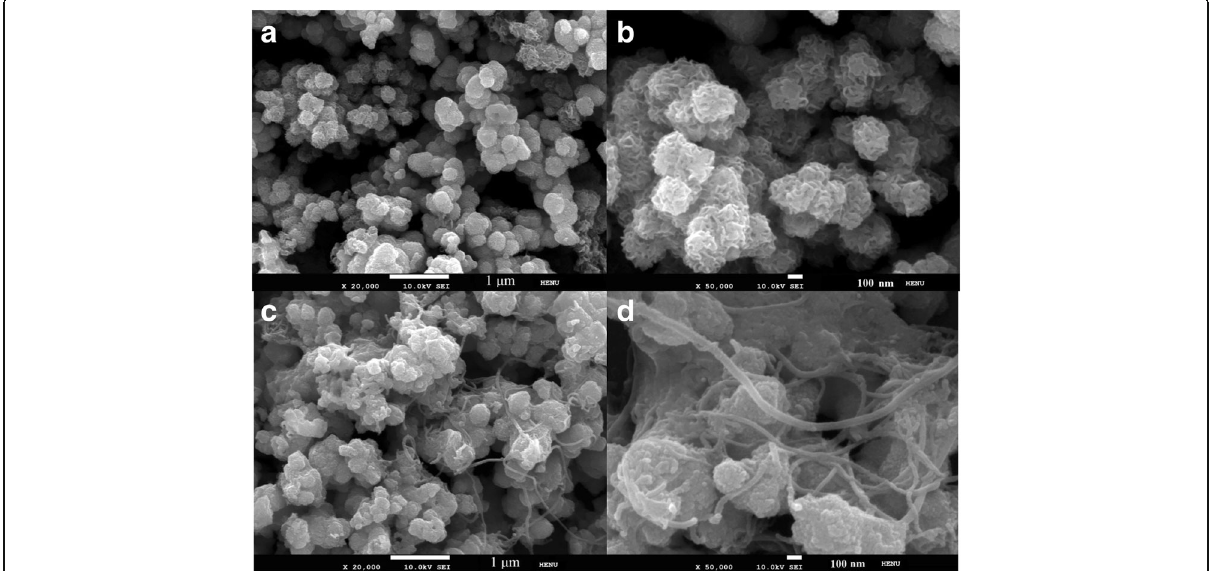
Fig. 1 The SEM images of the MoS 2 nanospheres ( a , b ) and the composite of MS1MWCNT1 ( c , d